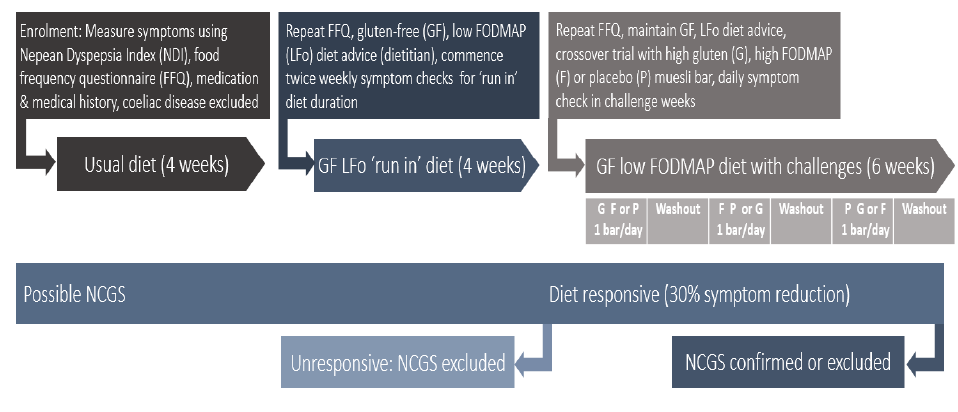
Figure 1. Non coeliac gluten/wheat sensitivity protocol overview including: ‘Run in phase’ (dark grey); baseline clinical testing, baseline diet assessment; gluten-free, low-fermentable oligo-, di-, mono-saccharides, and polyols (FODMAP) diet instruction by dietitian, four-week ‘run-in’ diet phase with pre-post symptom measurement, and second-daily dyspeptic symptom measurement; ‘Dietary challenge phase’ (dark blue); gluten-free, low-FODMAP diet continued, one challenge bar per day for one week (order of bars randomized) with high gluten, high fructan/FODMAP and placebo bars, with symptoms measured daily using a visual, analogue scale. Key: GF: Gluten free; FODMAP: Fermentable oligo- di- mono- saccharides and polyols; NCGS: Non-coeliac gluten sensitivity. Symptoms were assessed at baseline and after 4 weeks using the validated Nepean Dyspepsia Index (NDI) [22]. A food frequency questionnaire was used to calculate the change (mean, grams per day) in FODMAP intake over the run-in diet period [21], and a validated questionnaire was used to ensure compliance with the gluten-free aspect of the diet [23] (Figure A2). Those with a significant reduction in symptoms after the run-in diet (defined as ≥30% reduction in NDI score) were eligible